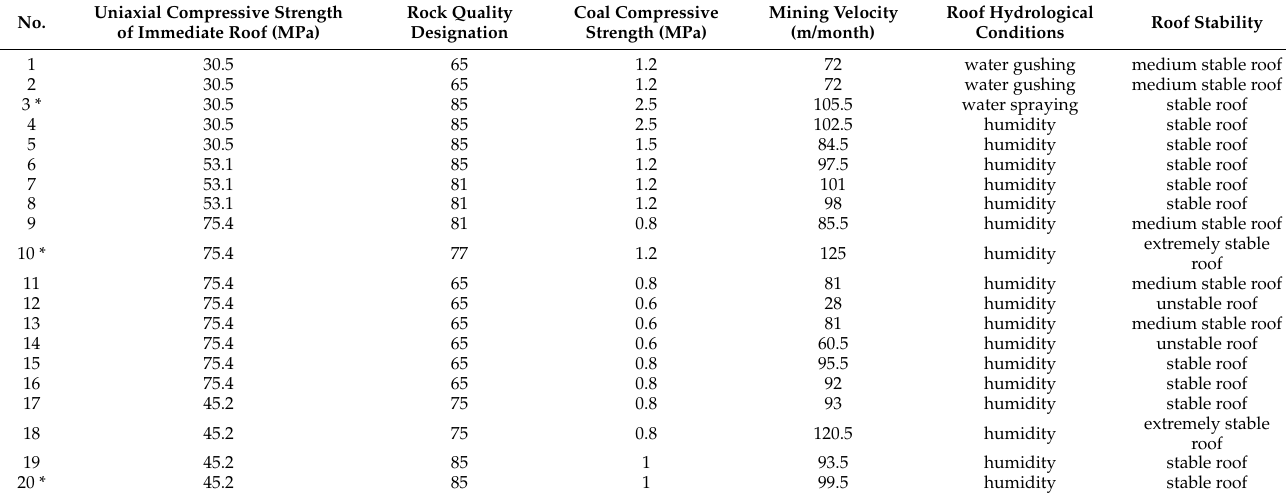
Table 3. Working face observation